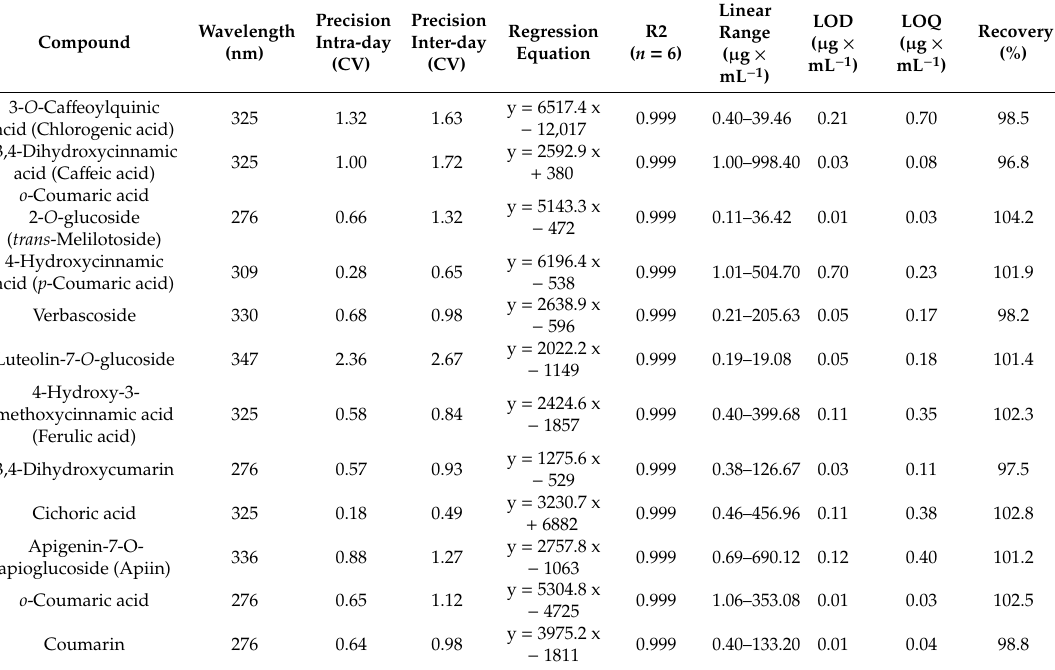
Table 5. HPLC-DAD validation parameters ( n =